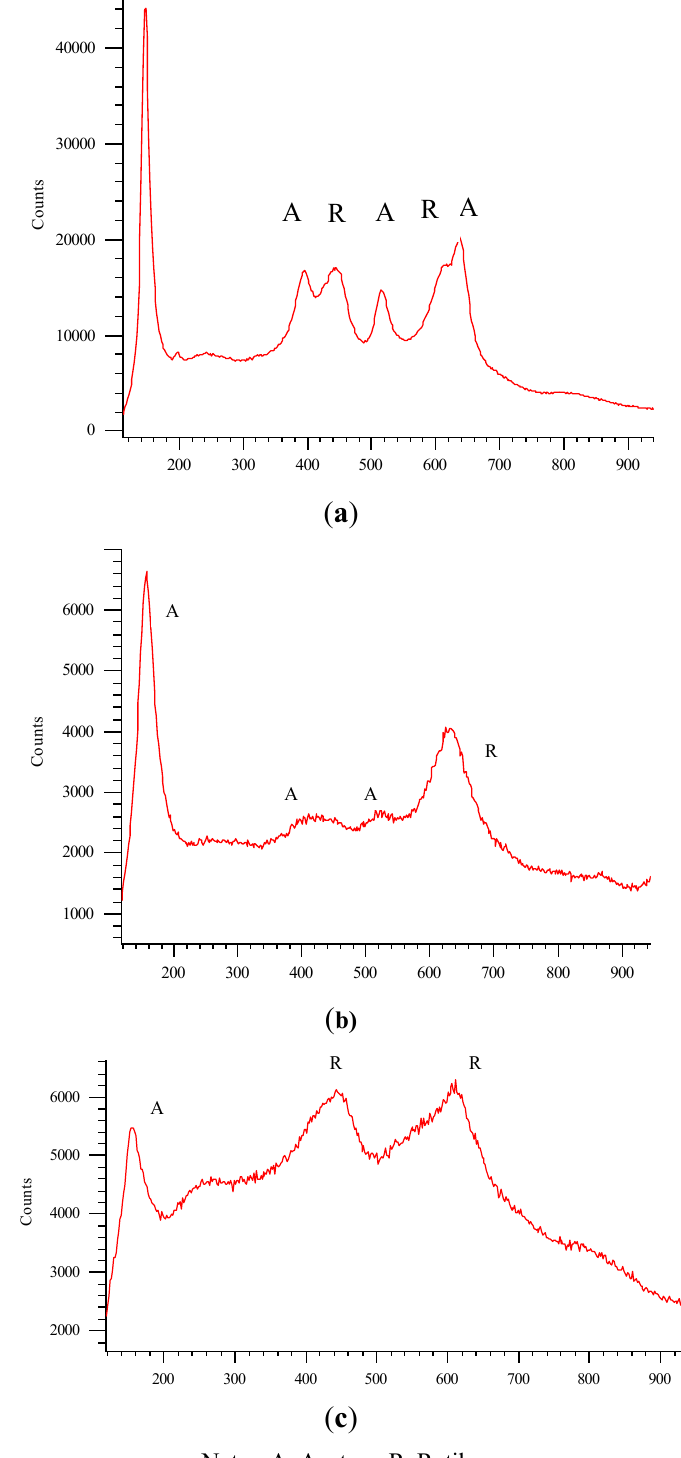
Figure 3. Micro-Raman spectra of ( a ) titania sample P4 produced on glass substrate at 250 kHz-50% Duty Cycle (TiO -6 atomic%W) after annealing at 700 °C, showing mixed 2 anatase-rutile structure; ( b ) titania sample P7 produced on glass substrate at 250 kHz-50% Duty Cycle (TiO -6 atomic%Nb) after annealing at 700 °C, showing mixed anatase-rutile 2 -6 atomic%ZnFe O ) produced on glass substrate after structure; ( c ) titania sample P10 (TiO 2 2 4 annealing at 700 °C, showing RU/AN